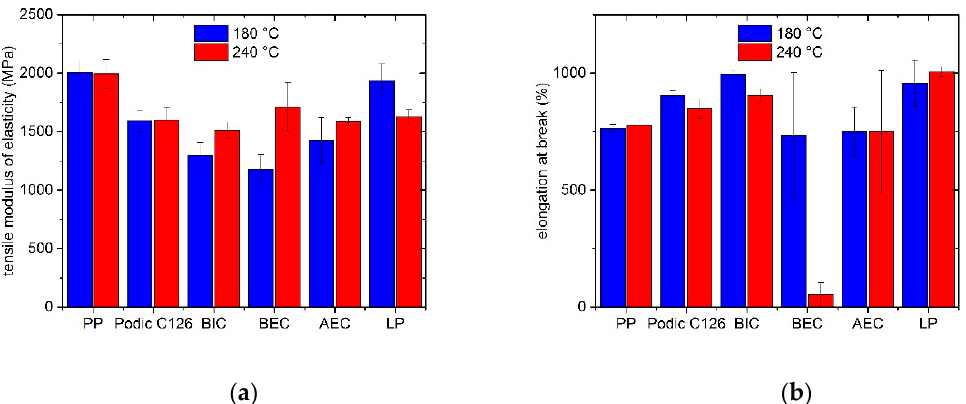
Figure 12. Results of the tensile test: ( a ) tensile modulus of elasticity and ( b ) elongation at break of the model mixtures extruded at 180 °C and 240 °C.